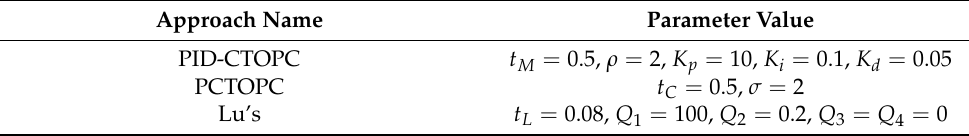
Table 1. Values of controller